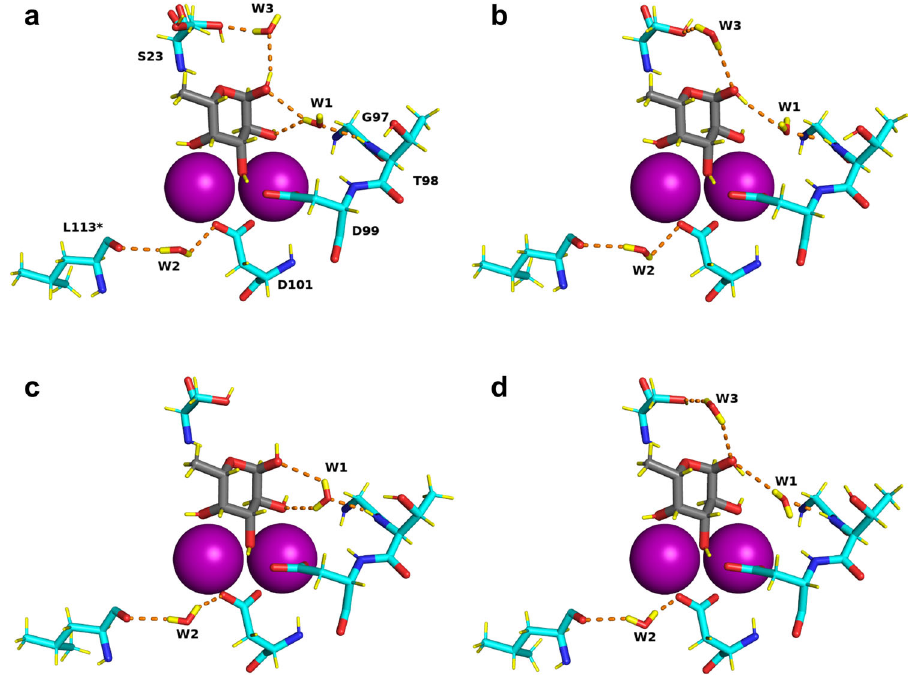
Fig. 5 Water network in the fucose-binding sites of the perdeuterated LecB/Fuc-d 12 complex determined from the neutron structure. a – d represent binding sites in chains A, B, C, and D, respectively. Calcium ions are represented by purple spheres. Hydrogen bonds are shown as orange dashed lines. Water molecules in the binding sites are shown in stick